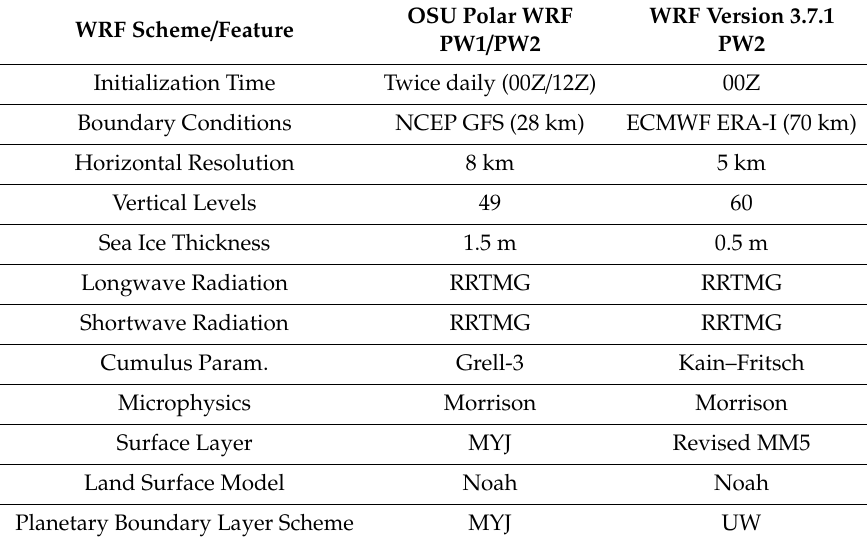
Table 3. WRF Specifications and Parameterizations used in this study.